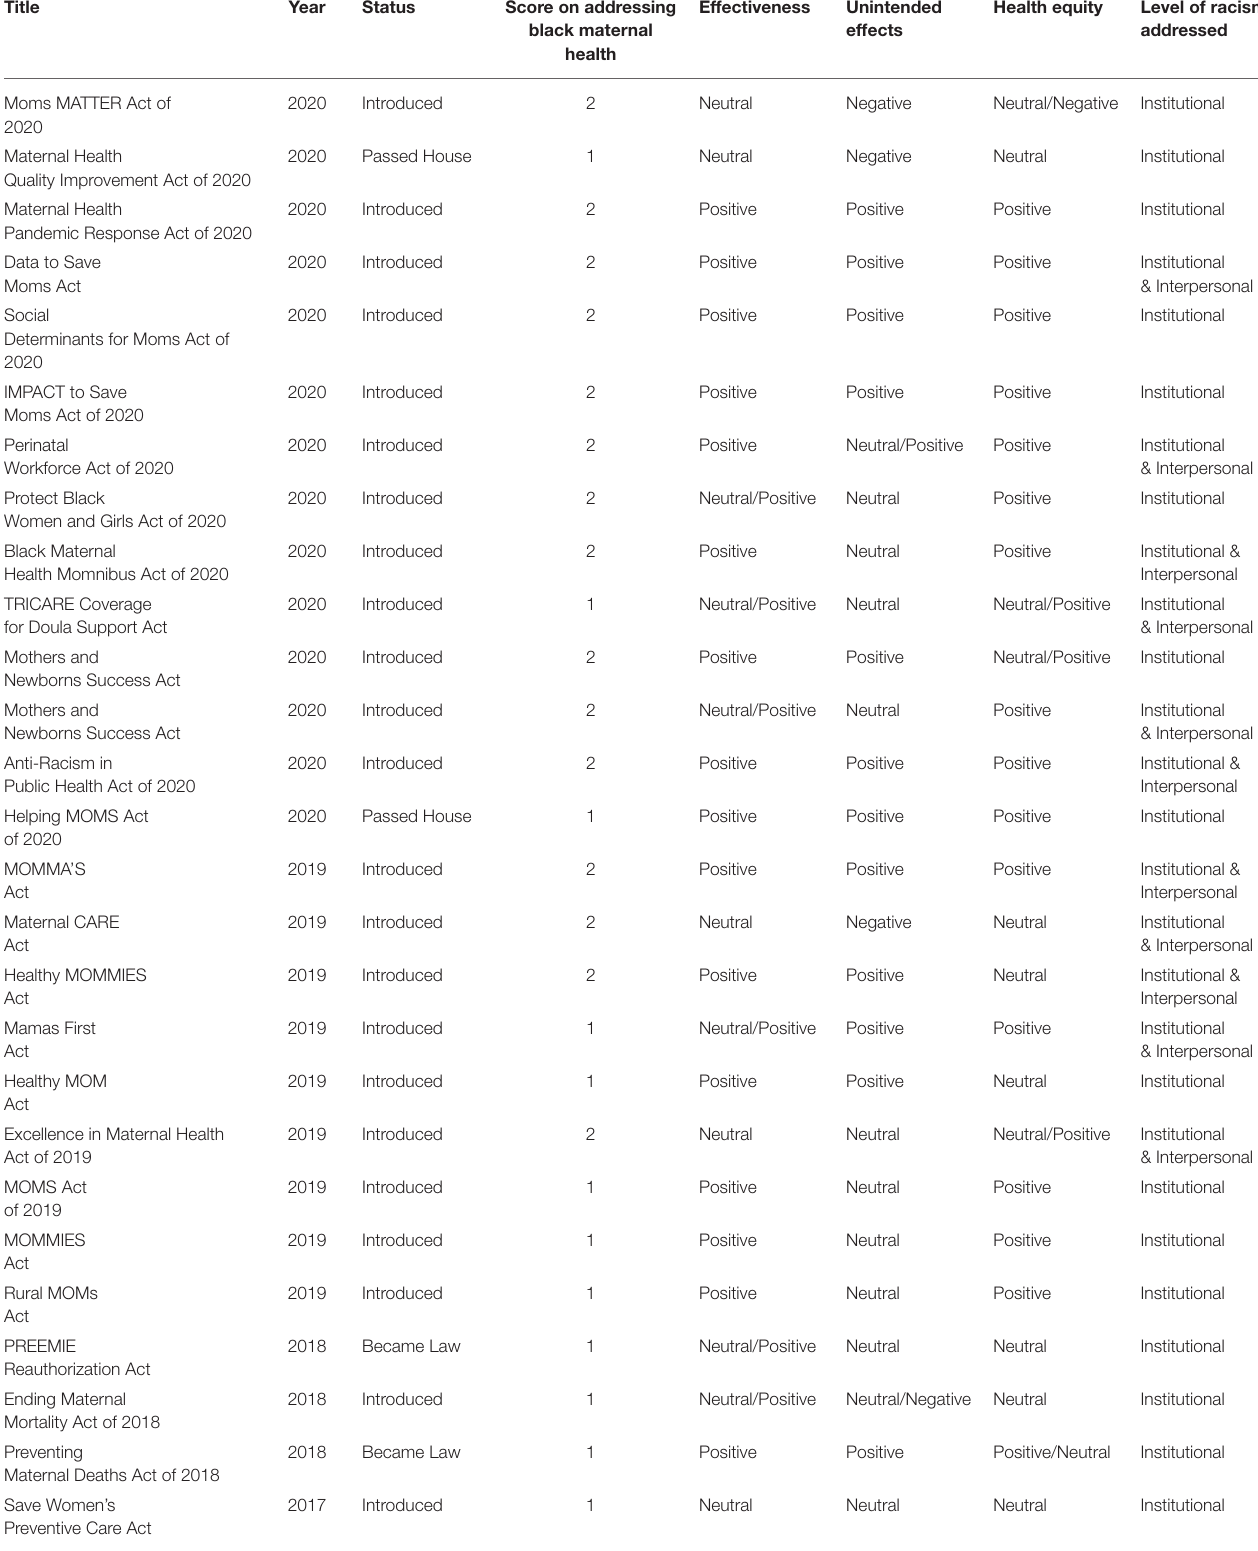
TABLE 3 | Summary of quality appraisal, status, and category ranking of included national